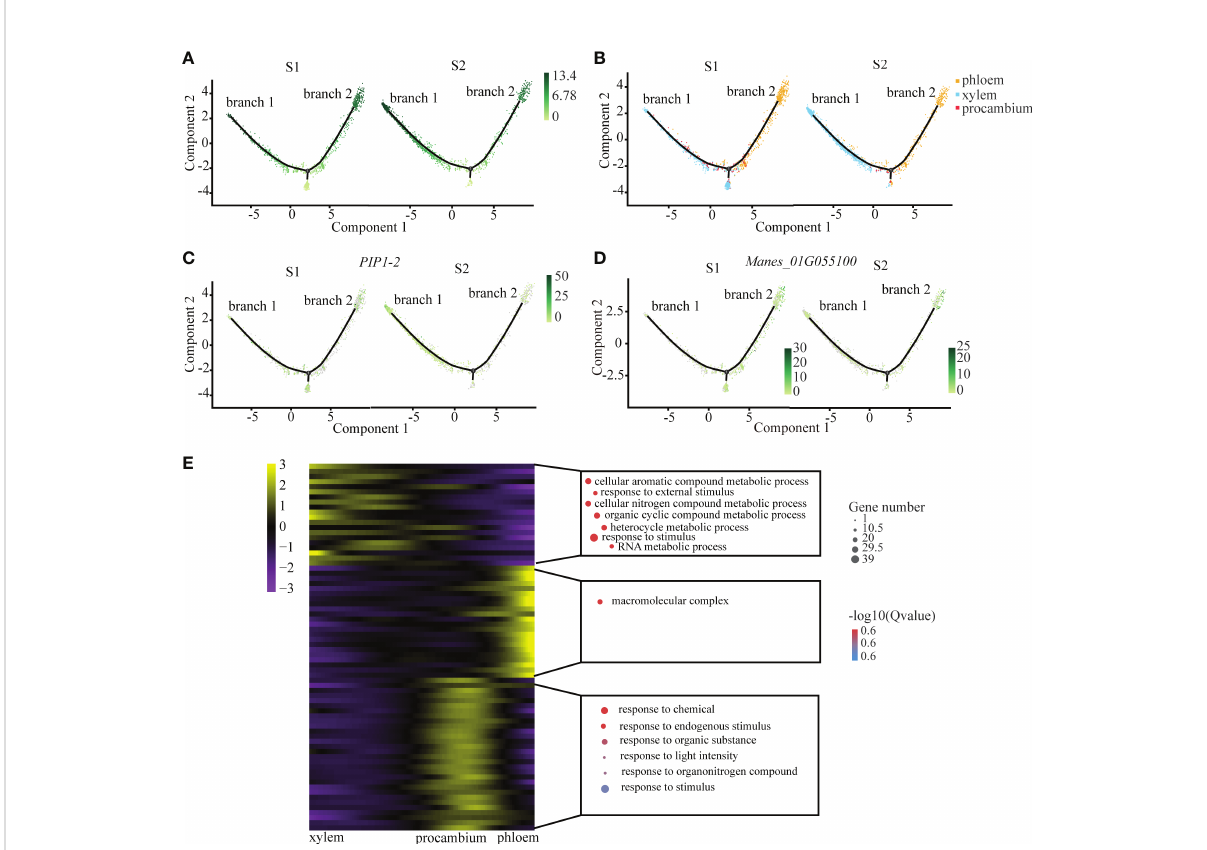
FIGURE 2 Differentiation Trajectory of the Xylem and Phloem. (A) Single-cell transcriptome data revealing the differentiation trajectory of xylem, phloem and procambium from S1 and S2 analyzed by Monocle 2. Each dot indicates a single cell. Different color on the dots indicates the pseudotime scores (B) Cell types labeled on the differentiation trajectory for S1 and S2, respectively. (C, D) Cell trajectory analysis of differentiation fate of xylem marker gene PIP1-2 (C) and phloem marker gene Manes_01G055100 (D) from S1 and S2. Each dot indicates a single cell. Color on the dots indicates the expression abundance in corresponding parts. (E) Heatmap showing the expression of the genes regulating signi fi cant enrichment function in three clusters across the pseudotime. Each row represents one gene. Scatter plots of representative GO terms for each cluster are shown on the right. The corresponding genes in the heatmap are listed in the supplementary table of CT